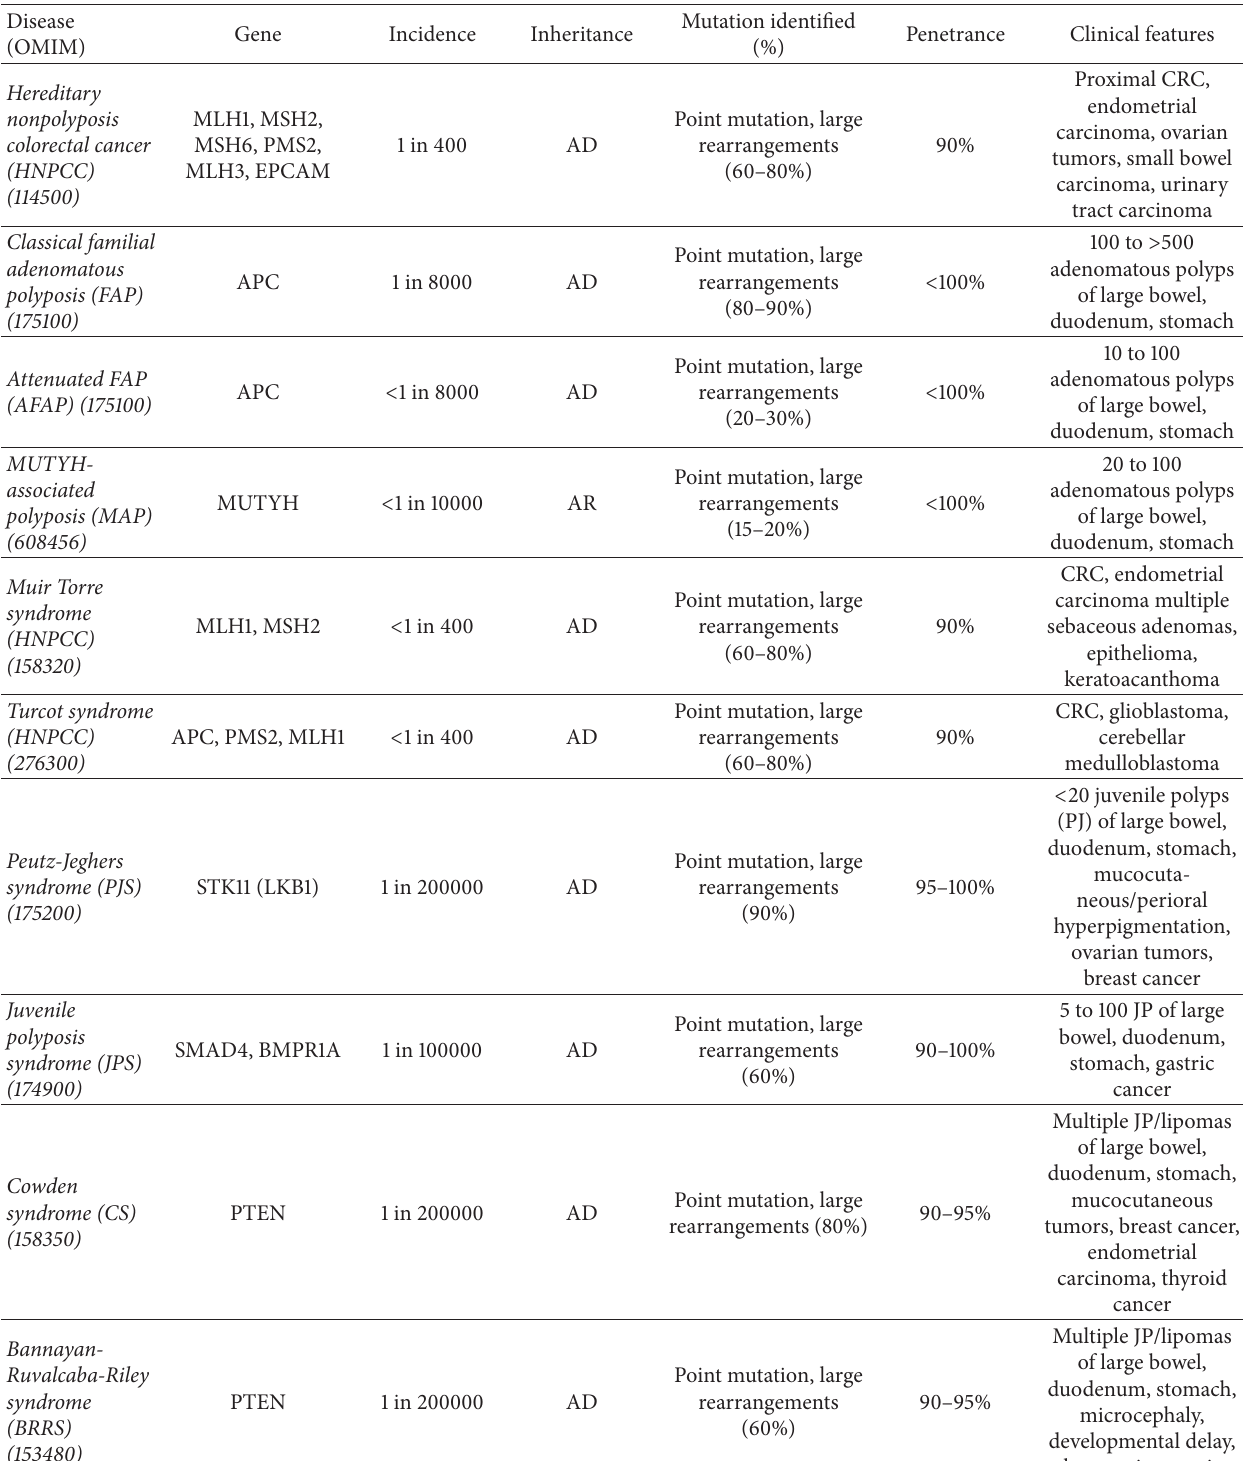
Table 1: Hereditary colon cancer syndromes: clinical and genetic features. (AD, autosomal dominant; AR, autosomal recessive).